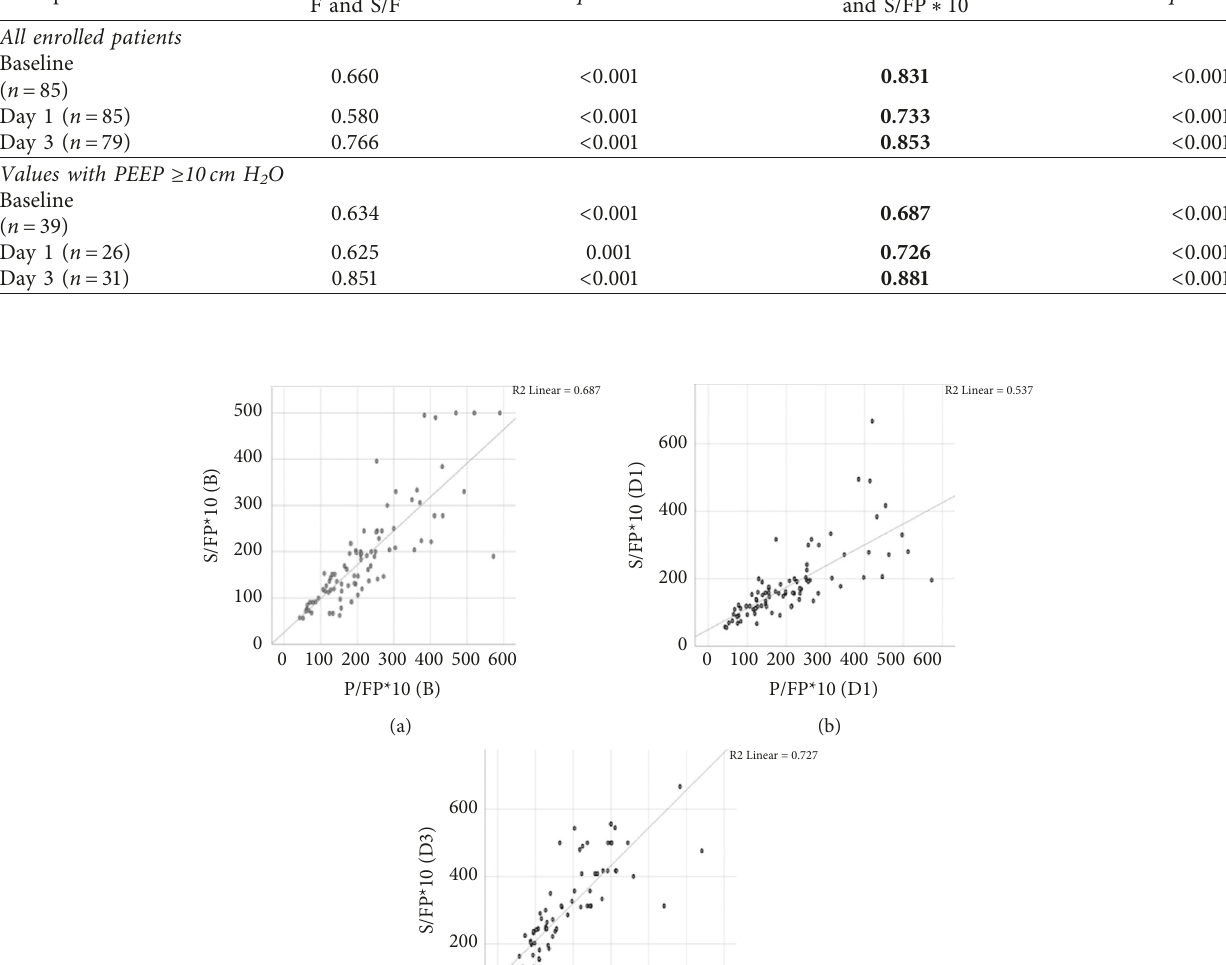
Table 2: Correlation between P/FP ∗ 10 and S/FP ∗ 10 at various time points and at high PEEP. Time